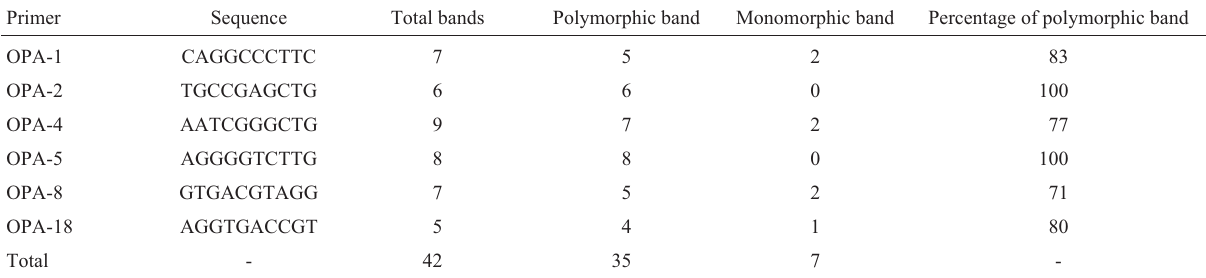
Table 2 - Polymorphism pattern of each primer selected for the genetic analysis of natural populations of E. dysenterica . Primer